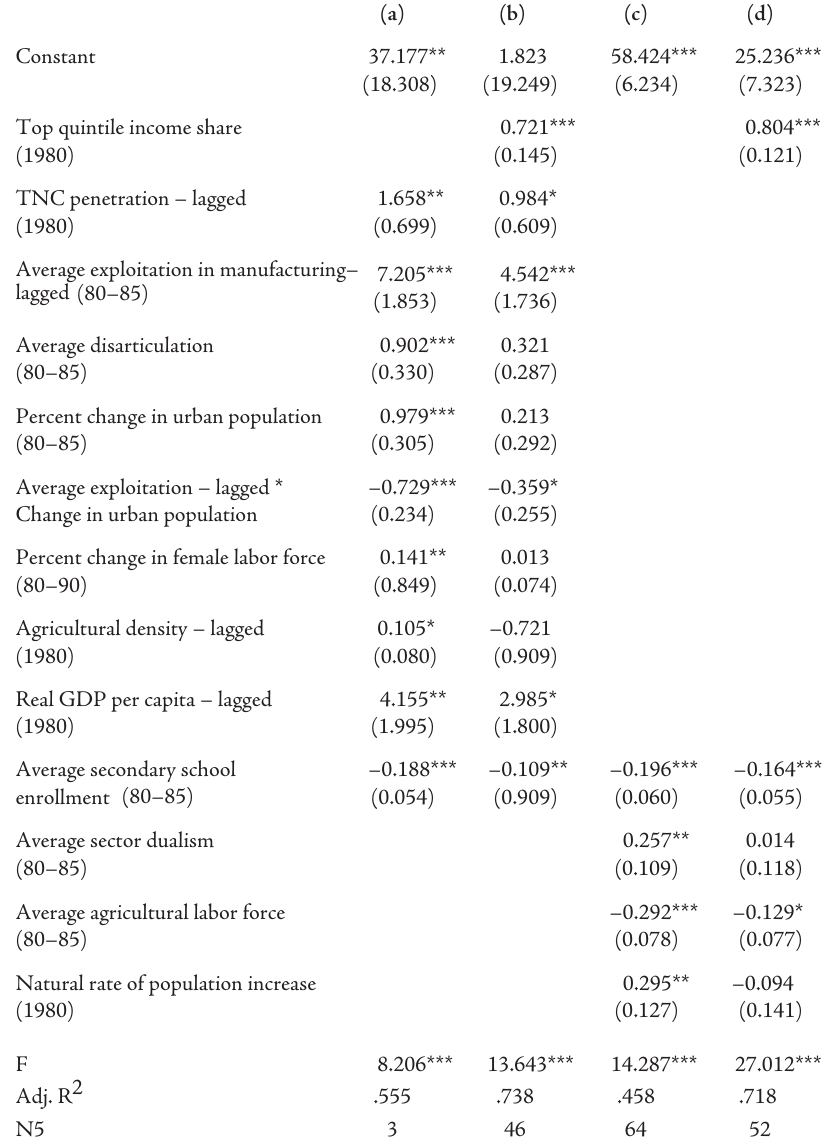
Table 3 – Comparison of Lagged Cross-Sectional and Panel Models